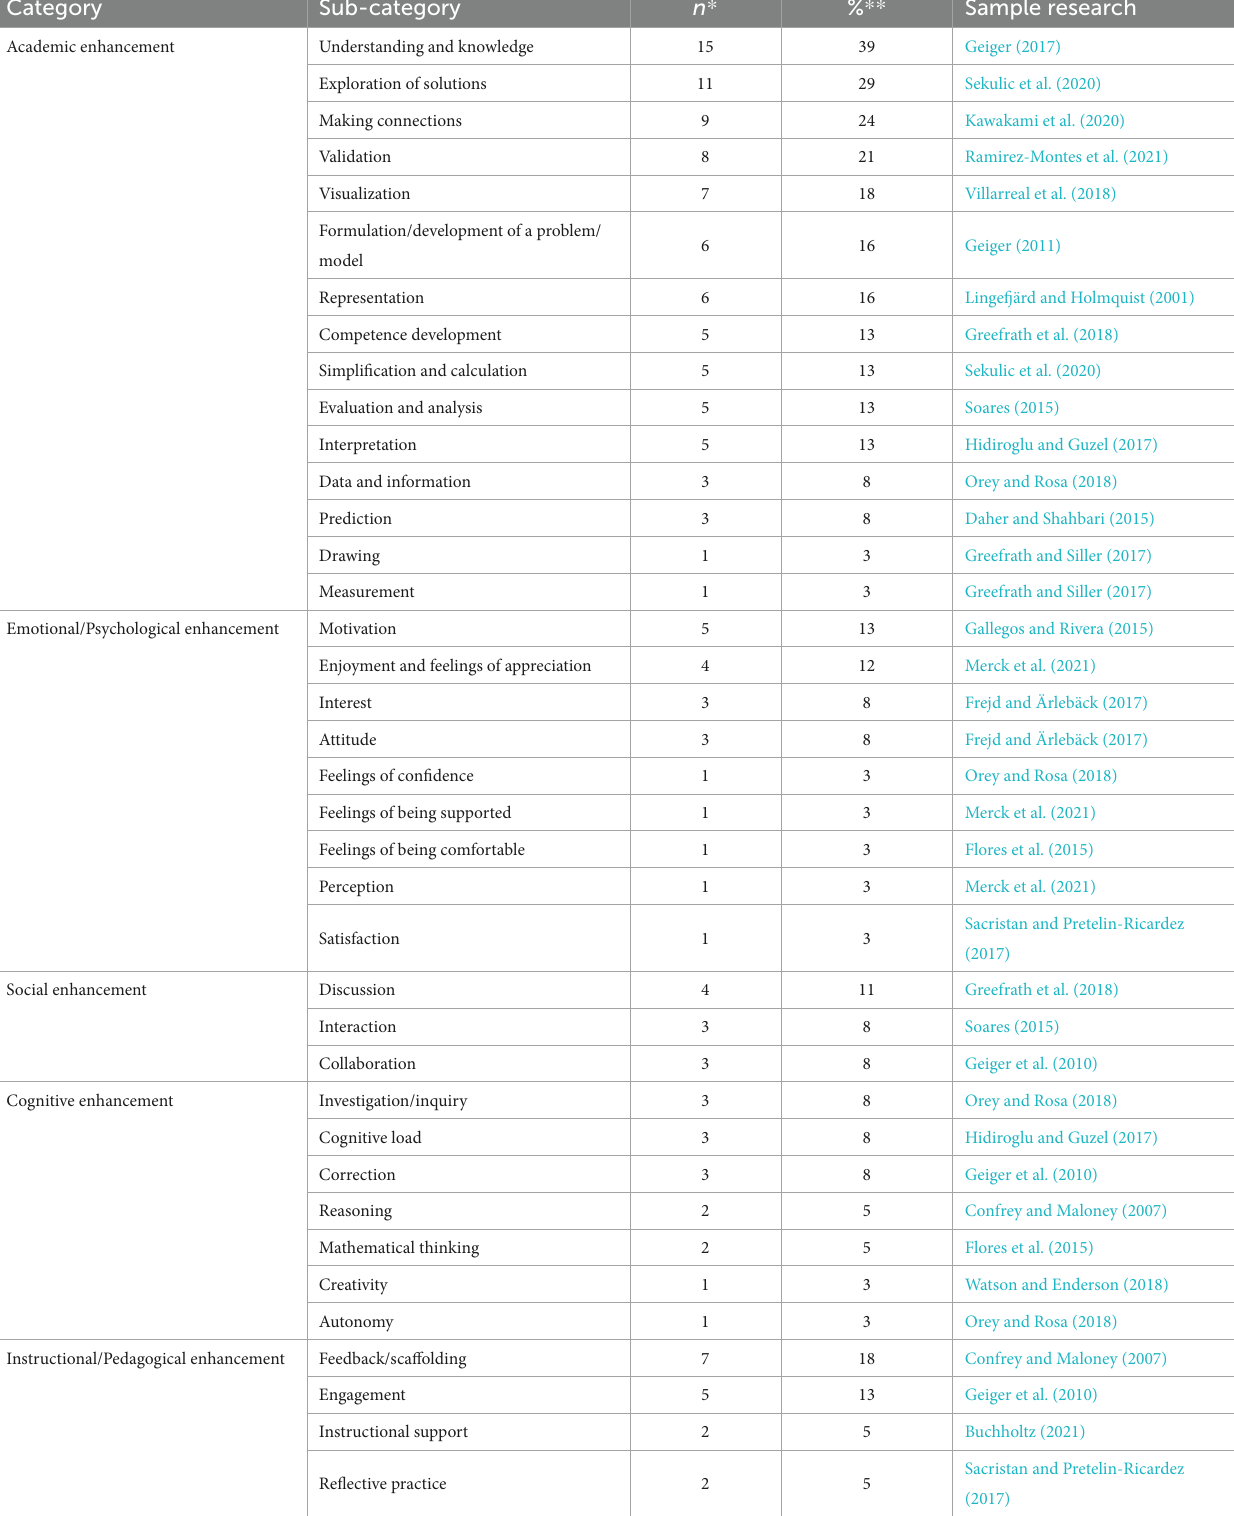
TABLE 6 Advantages afforded by technology in